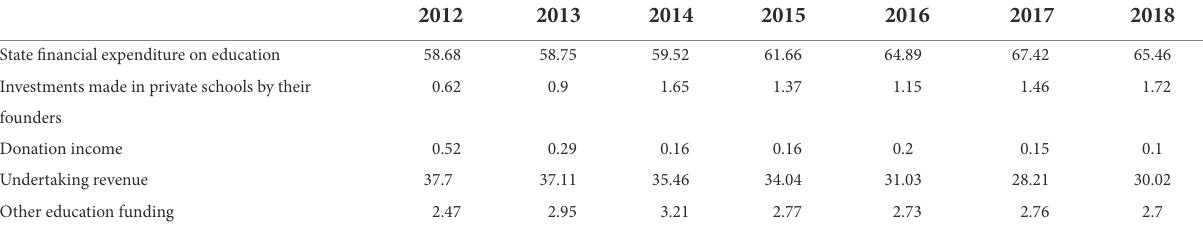
TABLE 5 Extent to which internal gap in education funding of different sources contributes to the overall gap.